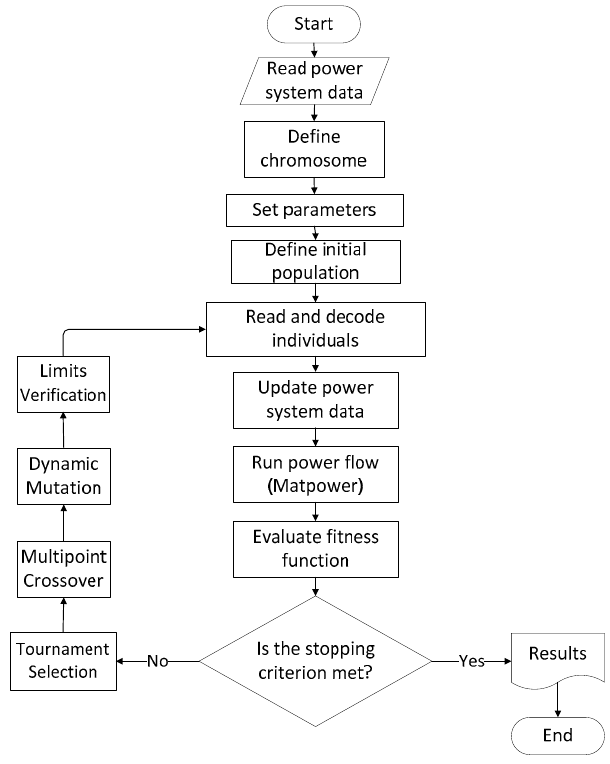
Figure 1. Flowchart of the implemented SGA.